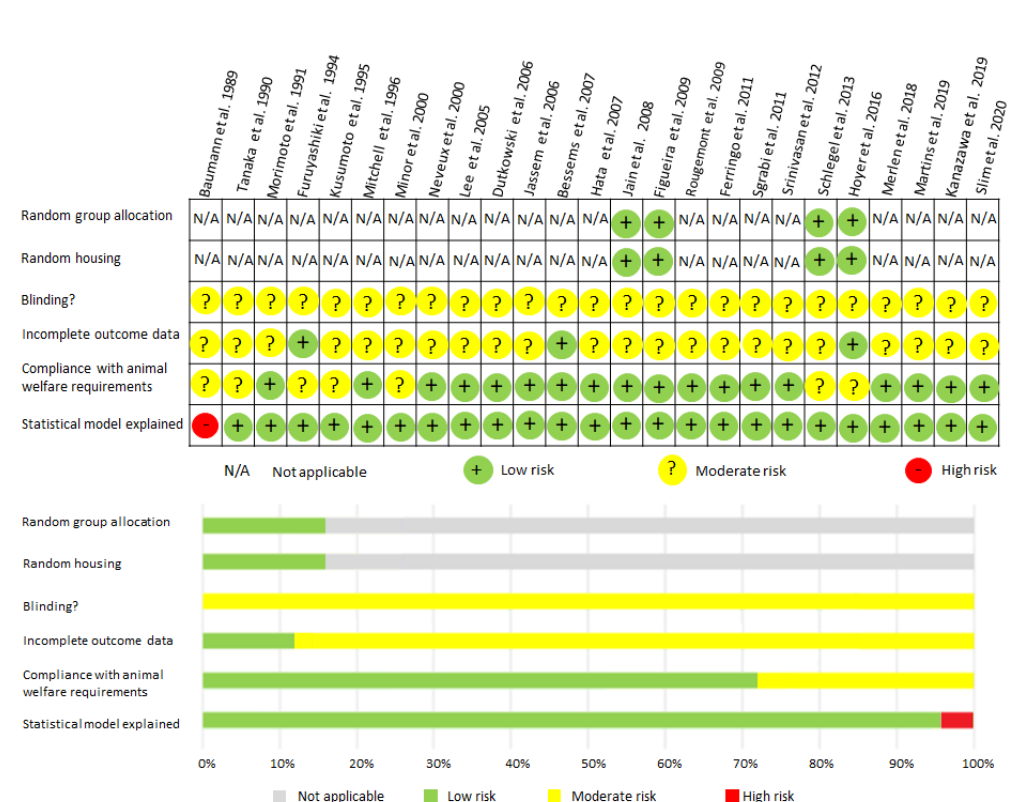
Figure 4. SYRCLE Risk of Bias analysis: Review of authors’ judgments about each risk of bias item for each study included.